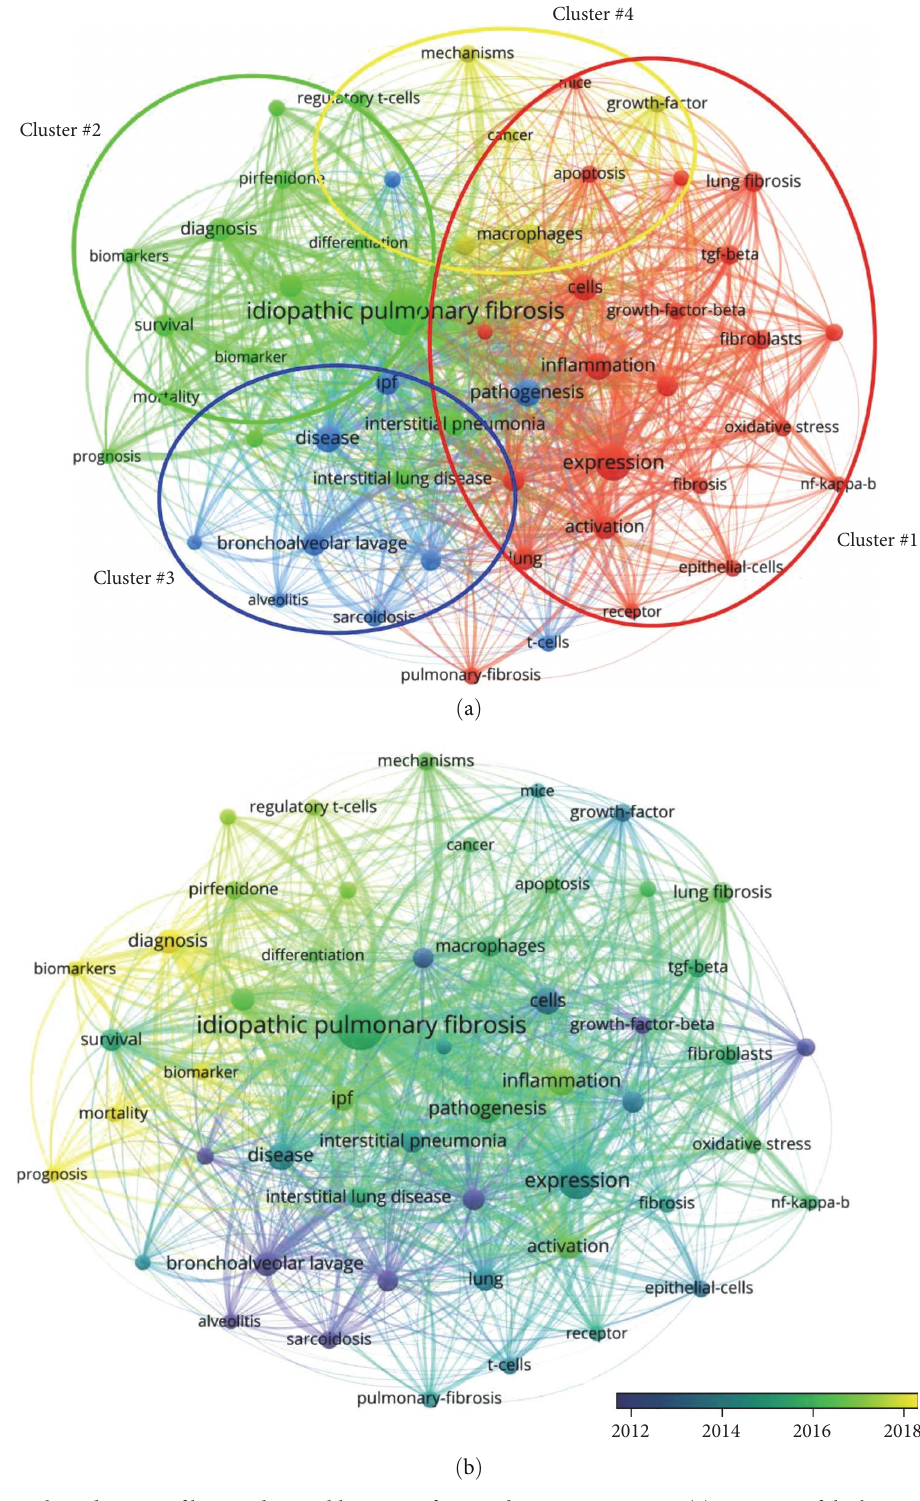
F IGURE 6: A cluster analysis diagram of keywords in publications of IPF and immune response. (a) Mapping of the keywords that appeared at least 20 times. Four clusters were automatically generated using VOSviewer software and defaulted to different colors. Each cluster was arti fi cially named “ in fl ammation related ” (right in red), “ biomarker related ” (left in green), “ disease related ” (down in blue), and “ innate immune mechanism ” (up in yellow). The circle size represents the frequency of occurrence. (b) Keywords were colored based on the average time of occurrence. Blue color represents in the early years, and yellow color represents more